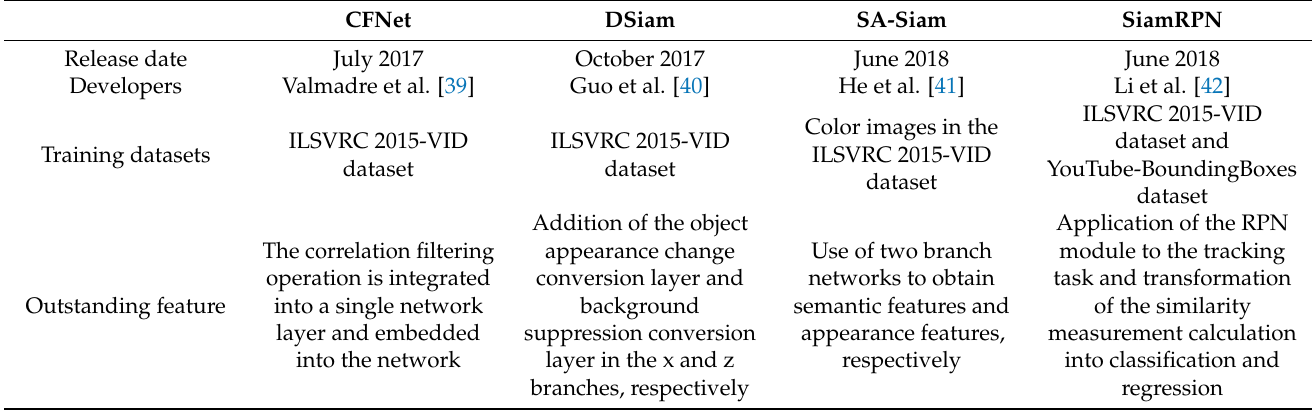
Table 1. A comparison of some Siam-FC-related